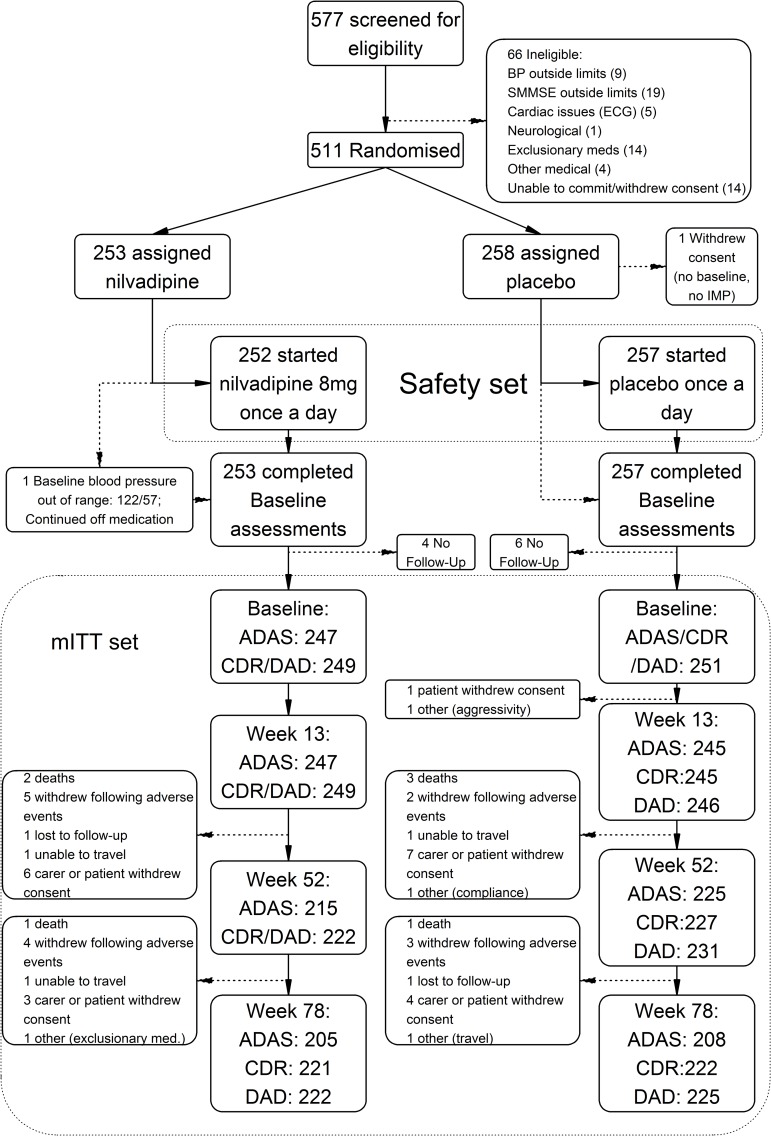
Flowchart of the NILVAD study according to the CONSORT guideline.ADAS, Alzheimer’s Disease Assessment Scale-Cognitive Subscale 12 item; BP, blood pressure; CDR, Clinical Dementia Rating Scale sum of boxes; DAD, Disability Assessment for Dementia; ECG, electrocardiogram; IMP, investigational medicinal product; NILVAD, Nilvadipine in Alzheimer disease; SMMSE, Standardised Mini-Mental State Examination.